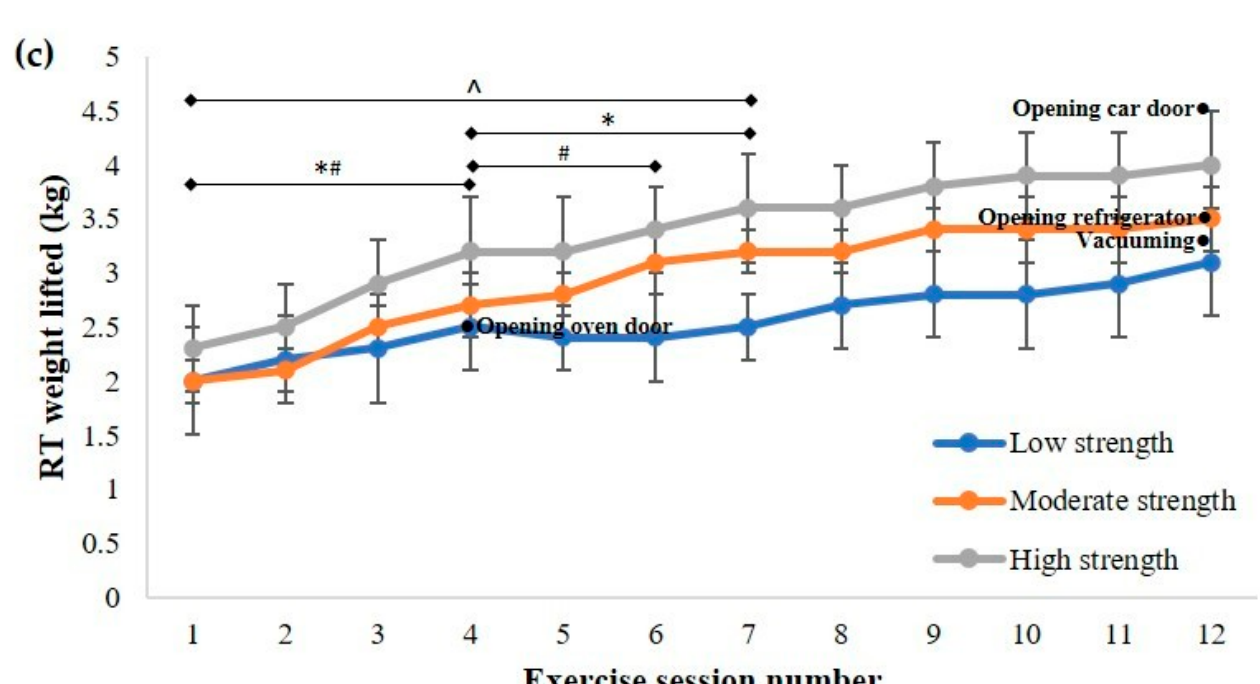
Figure 5. Comparison of resistance training (RT) weight lifted during cardiac rehabilitation with work required for activities of daily living, with patients categorised by ( a ) age; ( b ) cardiovascular intervention; and ( c ) initial grip strength tertile. Data presented as mean (95% CI). * Significant progression in weight lifted for ( a ) <65 years; ( b ) non-surgical intervention; and ( c ) high physical capacity. # Significant progression in weight lifted for ( a ) ≥ 65 years; ( b ) surgical intervention; and ( c ) moderate physical capacity. ^ Significant progression in weight lifted for ( c ) low physical capacity.